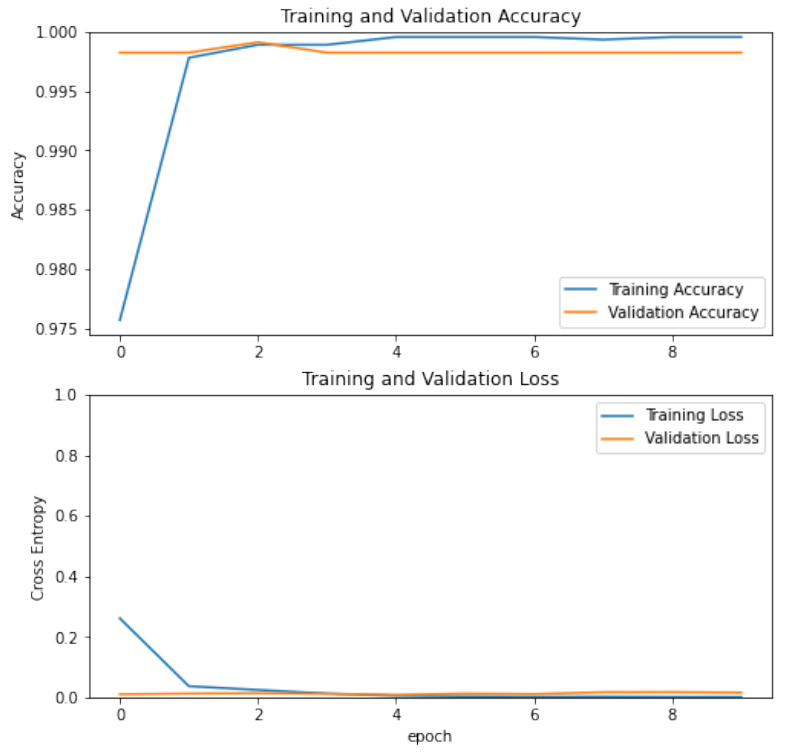
Figure 10. Training the model